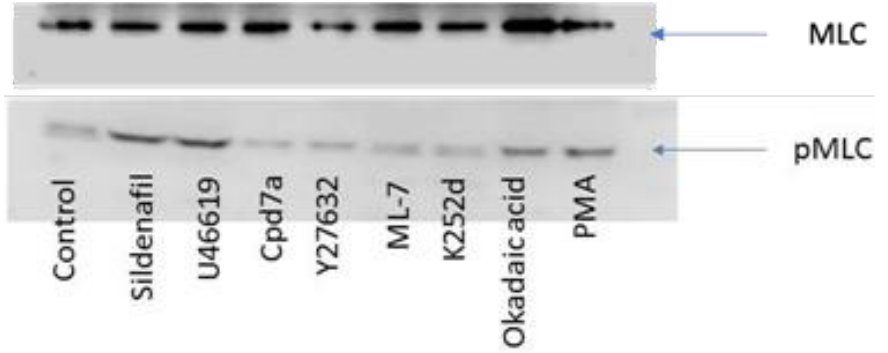
Figure 5. Western Blotting for pMLC detection. Platelet lysate was analyzed for the presence of pMLC after the addition of reagents. The addition of the activators U46619, sildenafil, PMA, okadaic acid resulted in increased MLC phosphorylation which coincided with increased platelet contraction forces. Blots are representative of five independent experiments. The total MLC band used to calibrate the increase in phosphorylation is